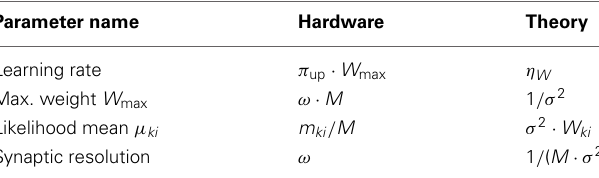
Table 1 | Correspondence of synapse parameters between the hardware and theory